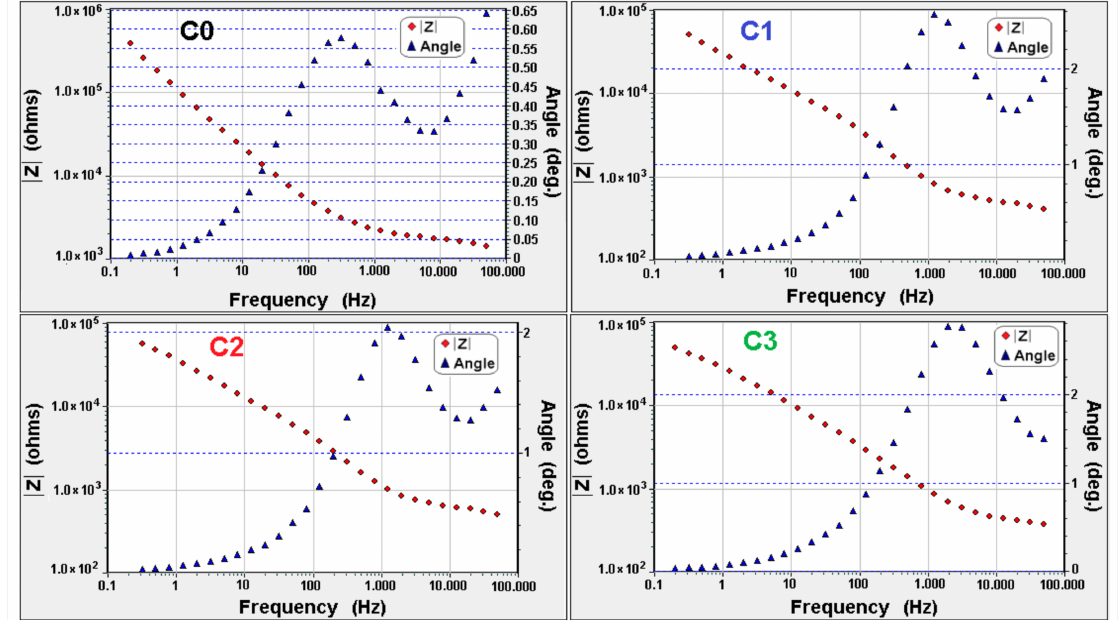
Figure 8. Bode diagrams for polymeric membranes with SiO 2 nanoparticles, before (C0) and after (C1–C3) 1 h of treatment. Proton conductivity ( σ ) of the polymeric membranes without and with SiO 2 nanopar- ticles was calculated from the bulk resistance that was determined from the high frequency intercept of the imaginary component of the impedance with the real axis. The calculated proton conductivities are presented in Figure